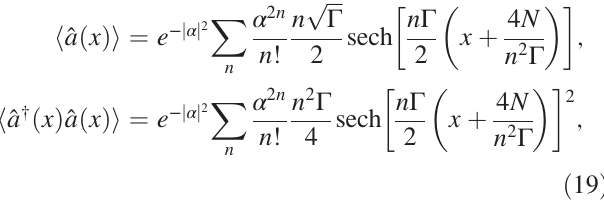
FIG. 3. (a) Output power for N ¼ 20 atoms for coherent input pulses with a solitonic shape (see text) and different mean photon number ¯ n . The results are computed by directly solving the ME (3) (solid lines) with the MPS algorithm where we fix D second panel, we include the results given in the many-body limit (19) (dashed lines), and in the third the mean-field solitonic ansatz (dotted line). We note that the x axis is limited to focus on larger photon-number components. (b) Maximum bond dimensions D the MPS calculations required to obtain a tolerance less than 10 − 4 versus input power ¯ n for different TLS number N . The blue shading highlights the regions for which panels (1) – (3) in (a) show the output